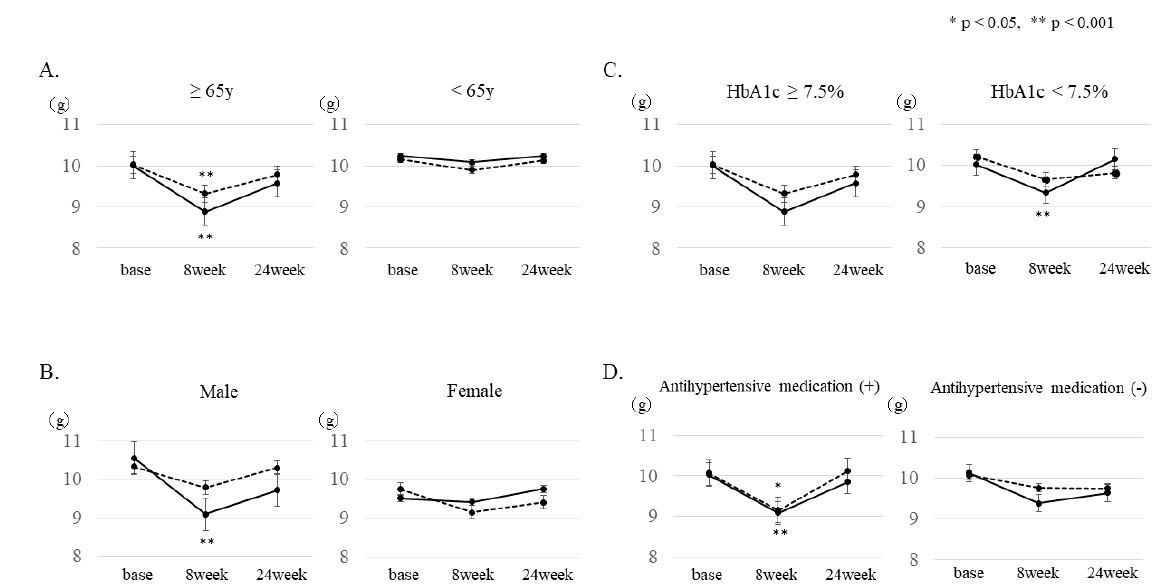
Figure 2. Subgroup analysis of changes in estimated salt intake. Changes in estimated salt intake 8 and 24 weeks after baseline were analyzed in the following subgroups: ( A ) age, ( B ) gender, ( C ) with or without antihypertensive drugs, and ( D ) HbA1c. A mixed model was used for the analysis. (* p < 0.05, ** p < 0.001). Solid line: IG, dotted line: CG.